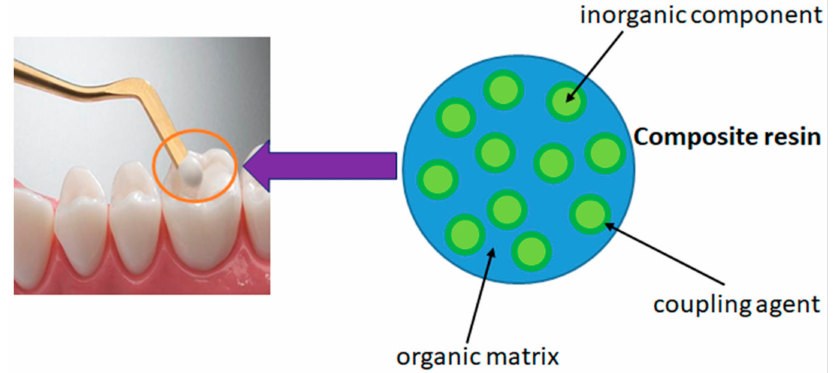
Figure 3. Graphical representation of composite resins.